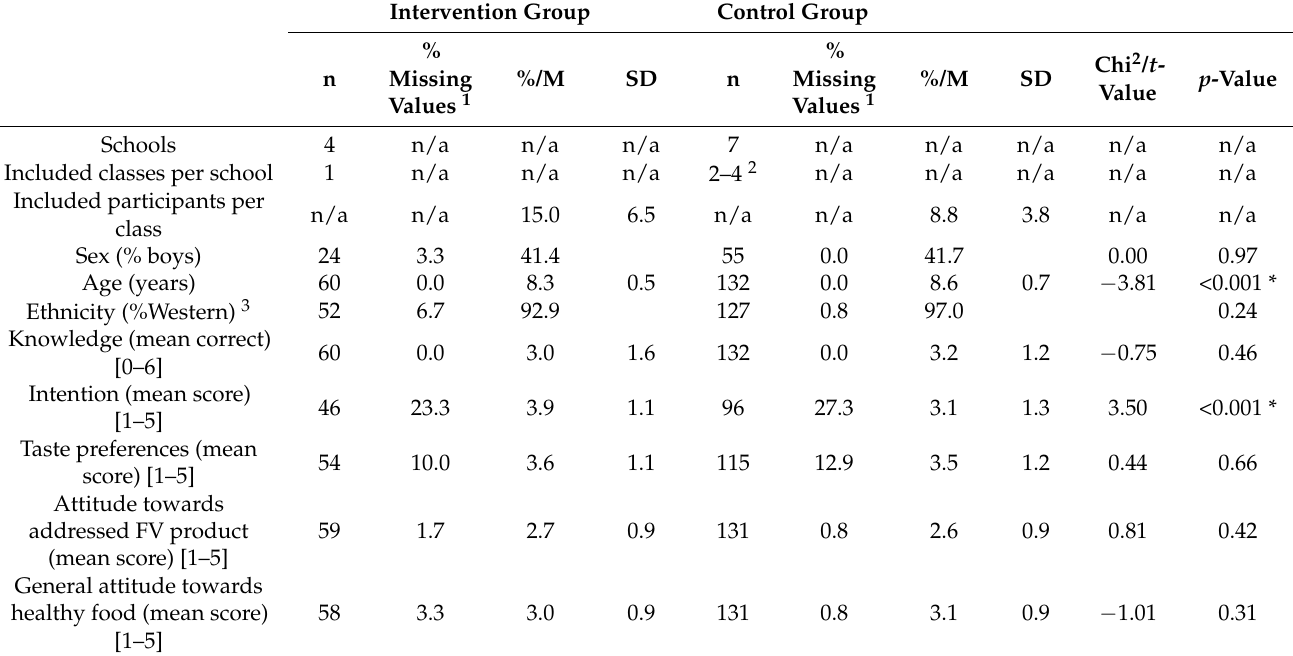
Table 1. Baseline characteristics of participants from the present study’s intervention and control group (n =